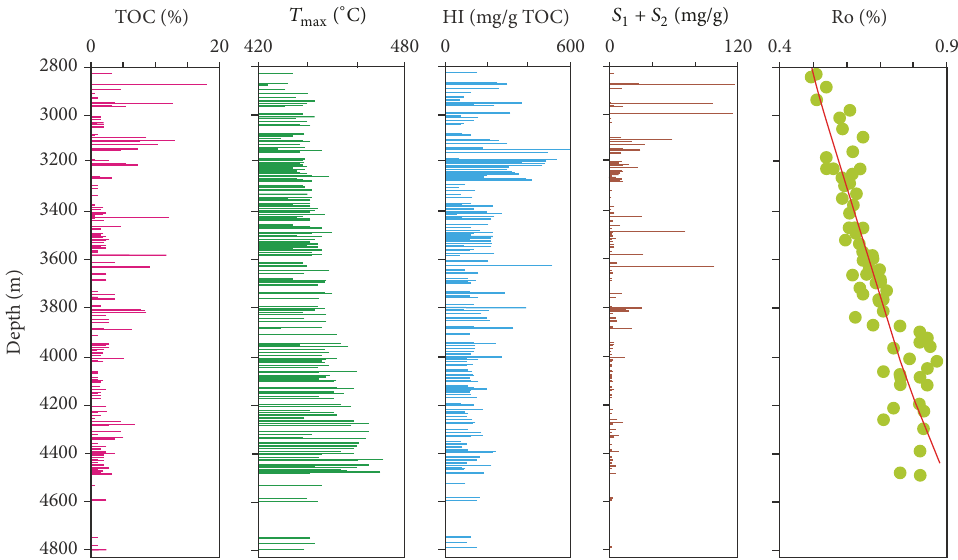
Figure 8: Measured geochemical parameters of the Eocene source rocks in the Huizhou Sag (HZS).